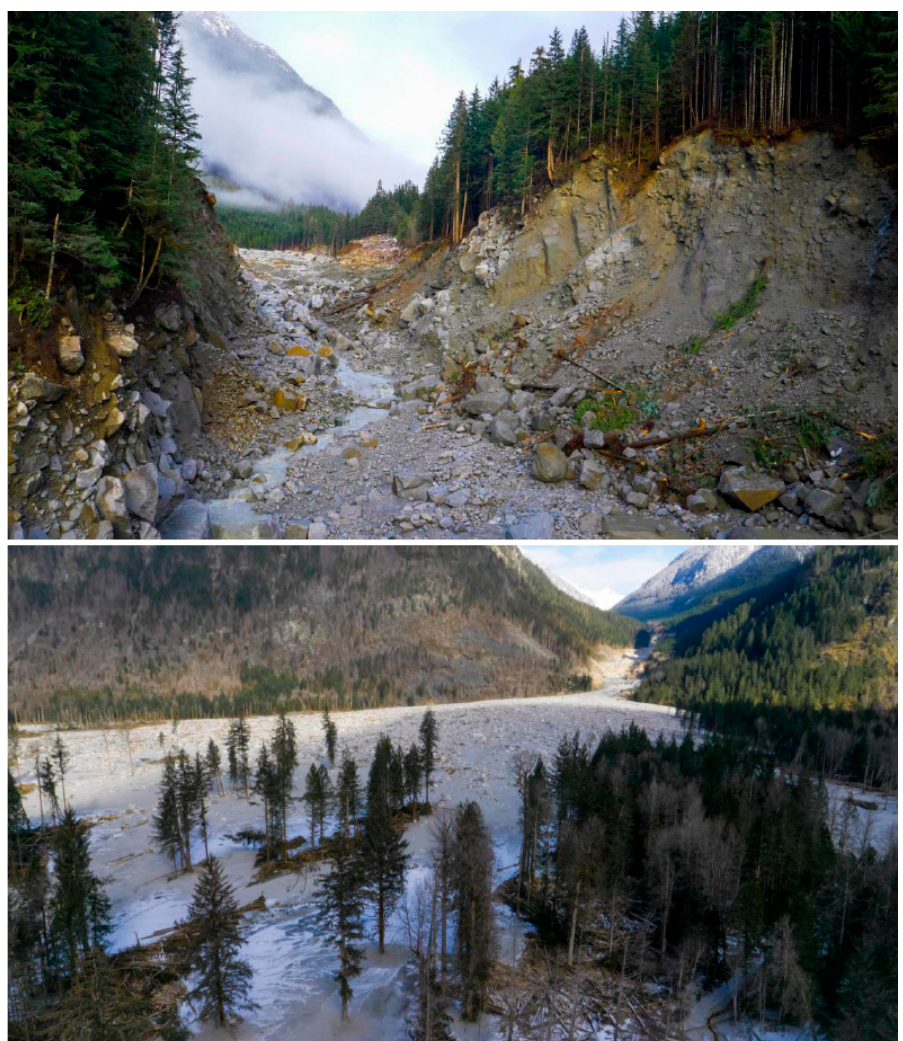
Figure 9. Top: Deeply eroded channel and fan of Elliot Creek following the outburst of Elliot Lake in the southern Coast Mountains of British Columbia (photos courtesy of Kat Pyne, Hakai Institute).